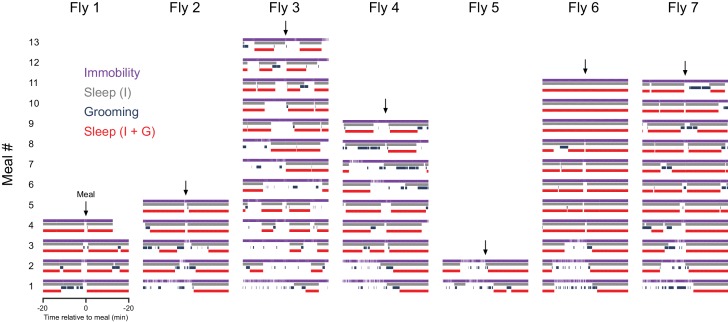
Grooming event influence on immobility based sleep.Ethograms of individual fly behavior in the 20 min before and after each meal, including immobility (purple), sleep (grey), grooming (blue), and recalculated sleep (red). n = 55 meals from seven flies, Canton-S.